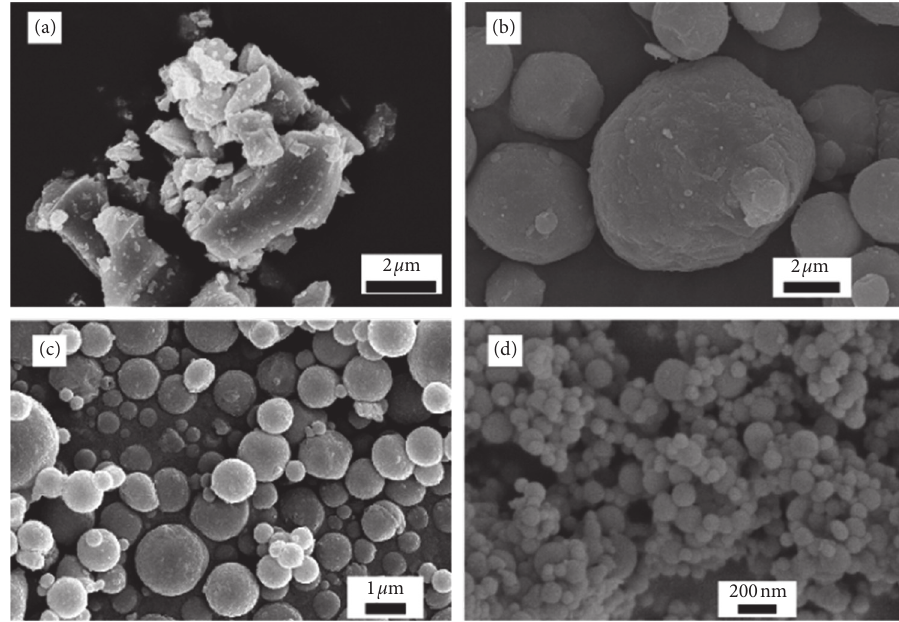
Figure 3: SEM images for the components: (a) micron-MnO 2 , (b) 5 μ m Al powder, (c) 1 μ m Al powder, and (d) nano-Al powder.